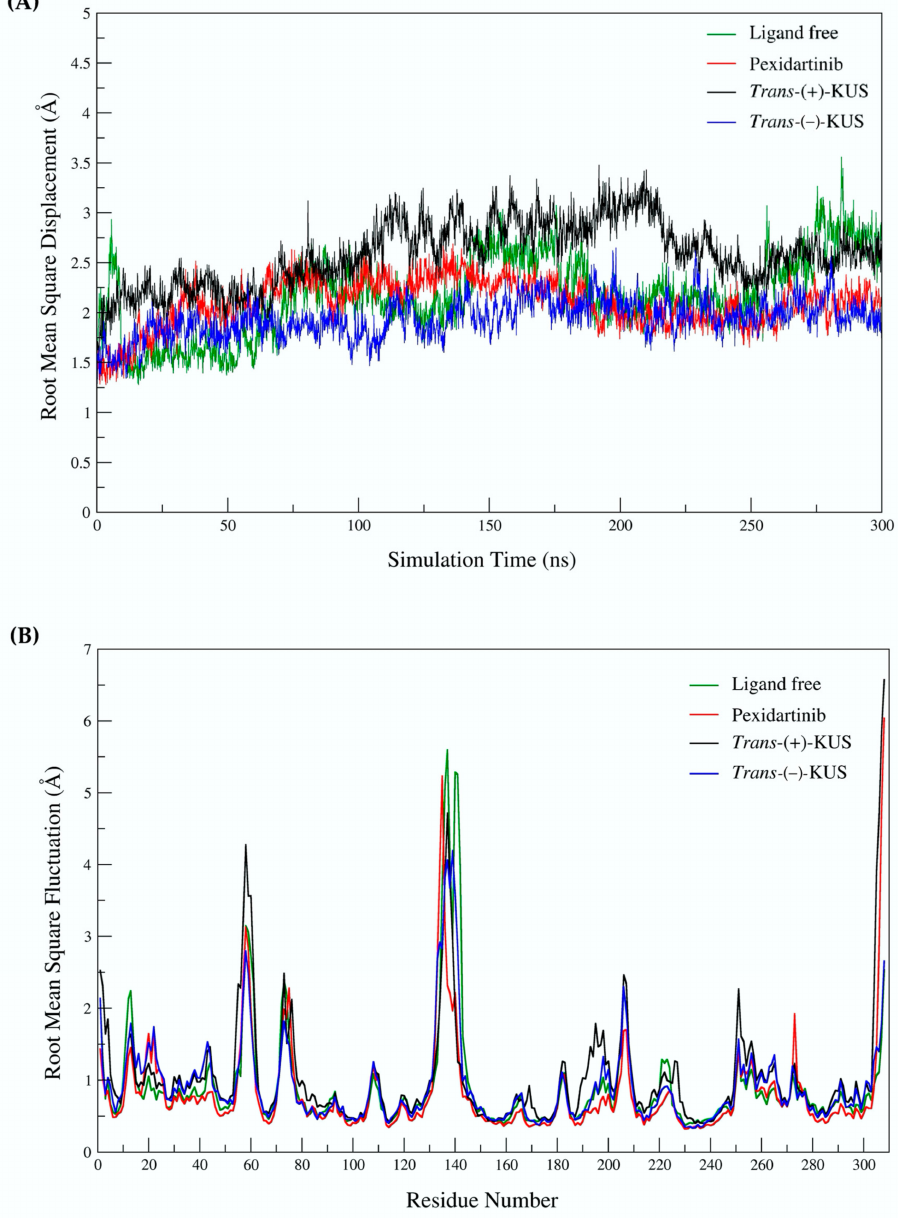
Figure 8. Structural parameters obtained from MD simulation: ( A ) root-mean square displacement (RMSD); ( B ) root-mean square fluctuation (RMSF). Both RMSD and RMSF were reported in Angstrom.